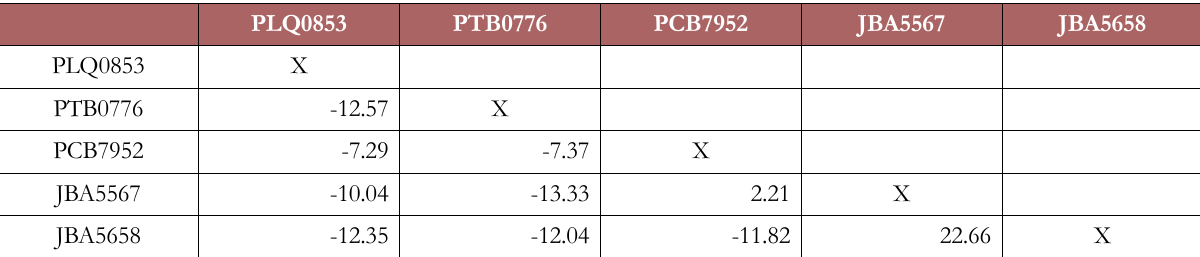
Table 6. Distance Intersections with Fuel Consumption in Kilometers